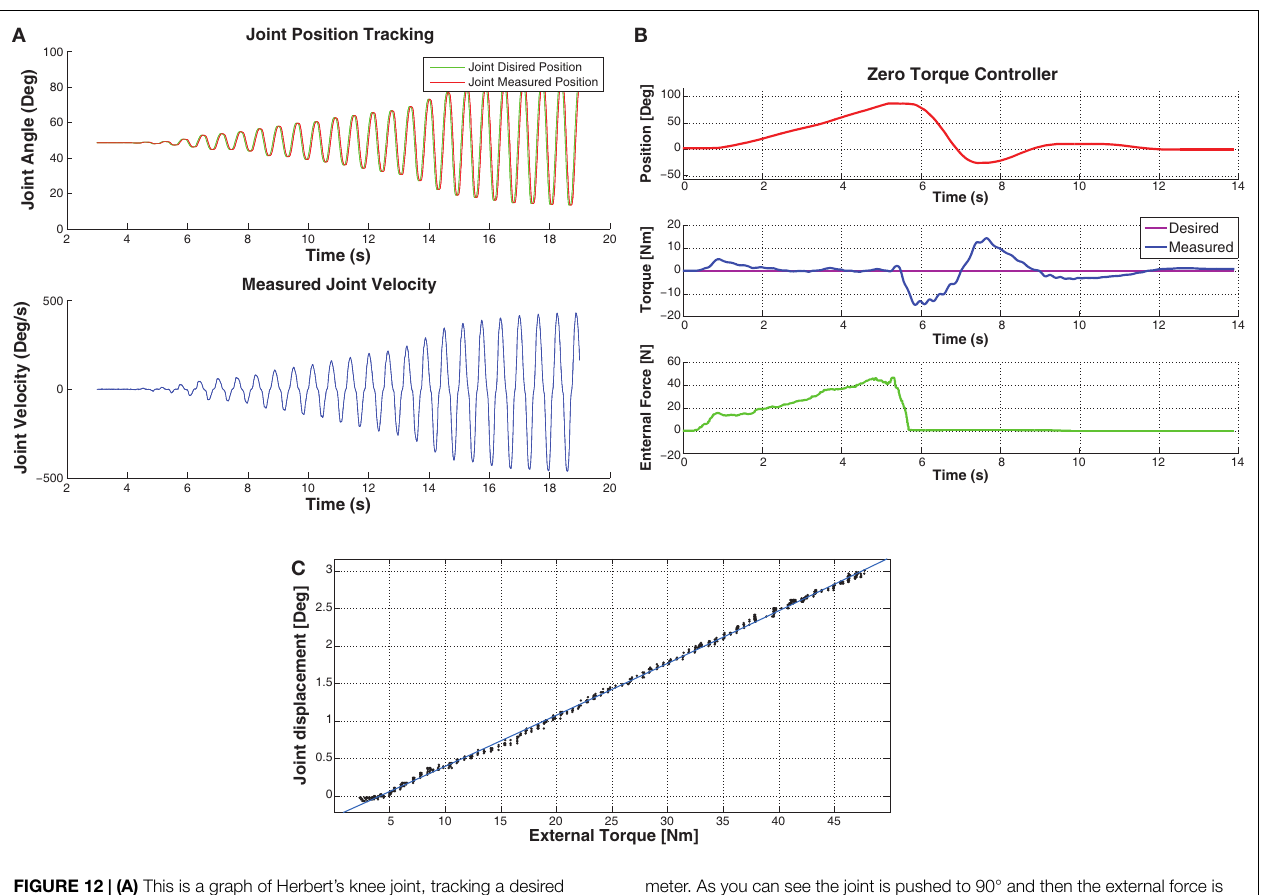
FIGURE 12 | (A) This is a graph of Herbert’s knee joint, tracking a desired position in the air. The main point of this graph is to demonstrate the maximum speed record, which was 462.8°/s while still tracking the desired position. (B) This graph demonstrates the torque controller. With the desired torque set to 0Nm for the hip pitch joint and then push with an external force